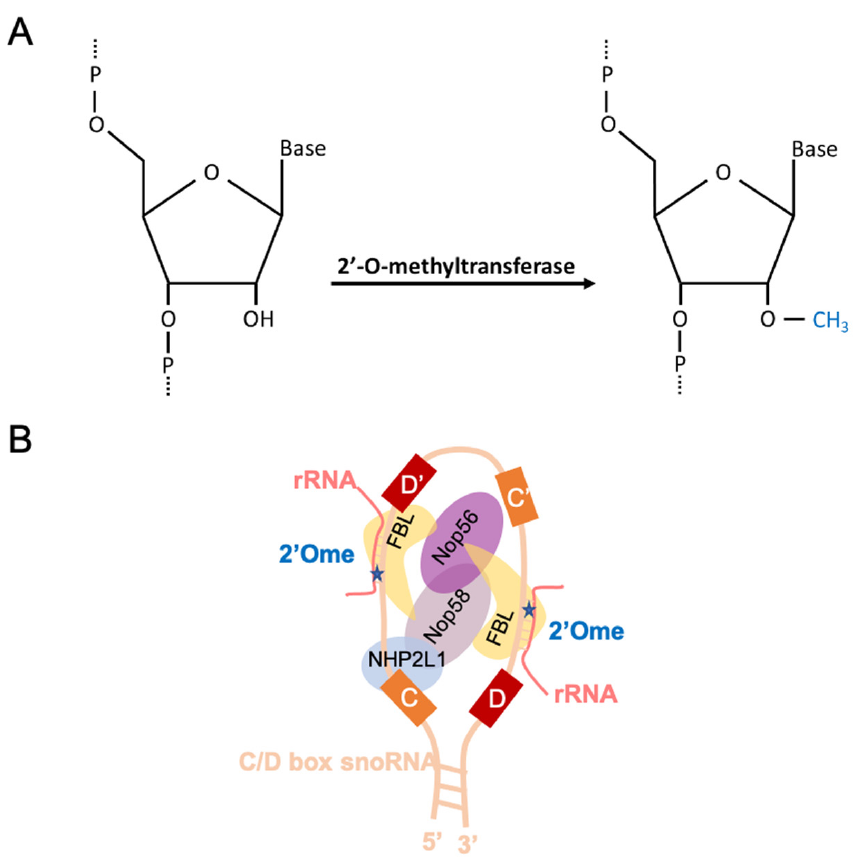
Figure 1. Schematic representation of a 2 (cid:48) -O-methylated ribose ( A ) and a C/D box snoRNP (also named the methylation complex) ( B ) The C/D box snoRNP includes the methyltransferase protein Fibrillarin (light yellow), NOP56 (purple), NOP58 (light brown), NHP2L1 (light blue), and the C/D snoRNA (light orange). Boxes C/C’ (orange) and D/D’ (red) are shown. The rRNA forms an RNA:RNA duplex with the C/D snoRNA. The FBL catalytic domain 2 (cid:48) O-methylates the fifth nucleotide downstream the boxes D or D’ and indicated by a blue